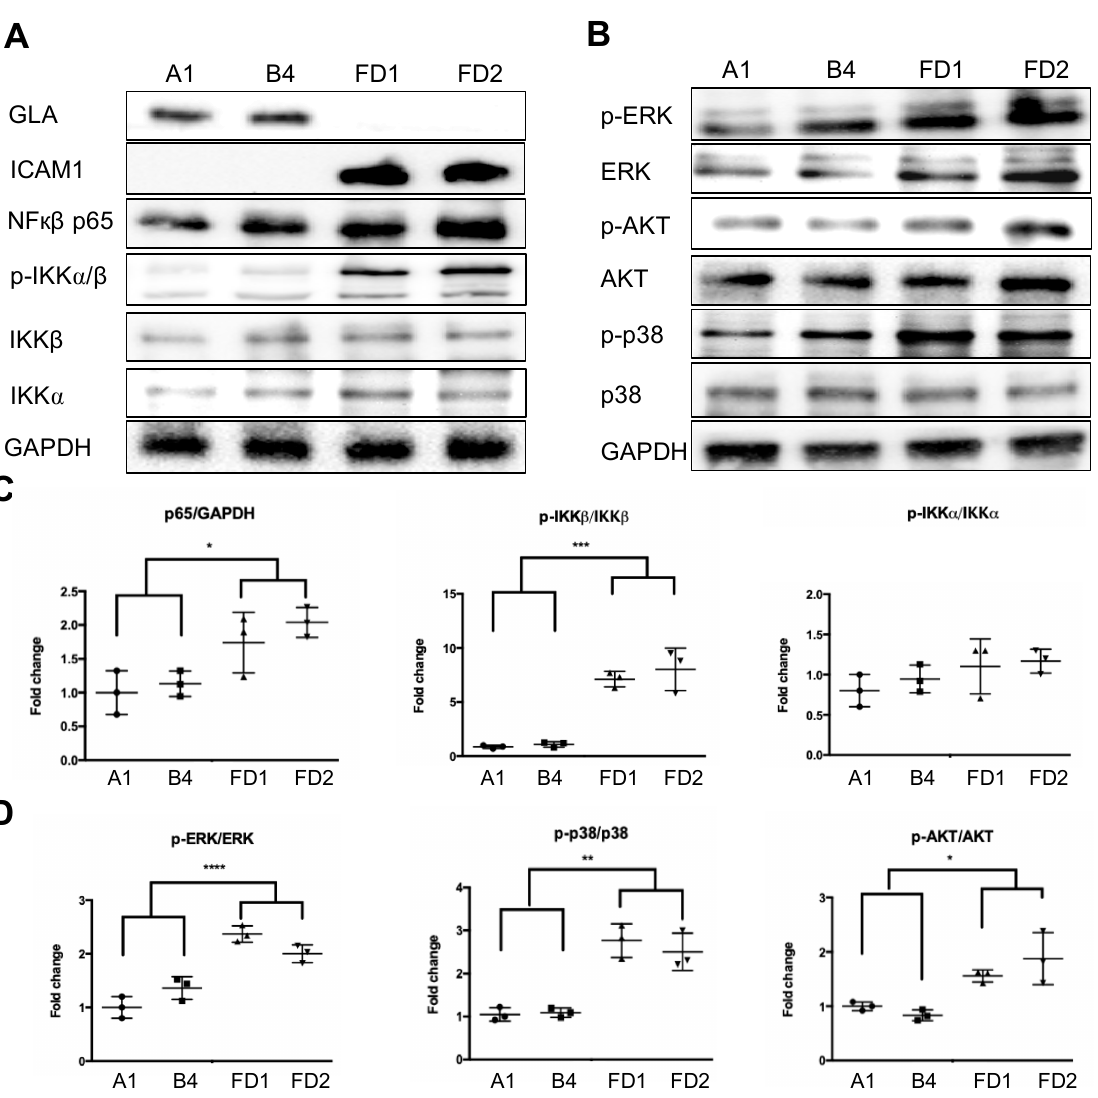
Figure 6. ( A ) Corrected FD-ECs attenuate NF- κ B and MAPK signaling pathway in comparison to FD-ECs. Expression levels of GLA, ICAM1, and p65, as well as the phosphorylation levels of IKK α and IKK β , examined by Western blotting. ( B ) Phosphorylation of ERK, AKT, and p38 in the MAPK signaling pathway examined by Western blotting. ( C ) Quantitative analyses of p65 expression and IKK α and IKK β phosphorylation in corrected FD-ECs compared to FD-ECs ( n = 3). ( D ) Quantitative analyses of phosphorylation of ERK, AKT, and p38 in corrected FD-ECs compared to FD-ECs ( n = 3). Error bars represent SD. One-way ANOVA was used for statistical analysis (* p < 0.05; *** p < 0.005; **** p < 0.001).